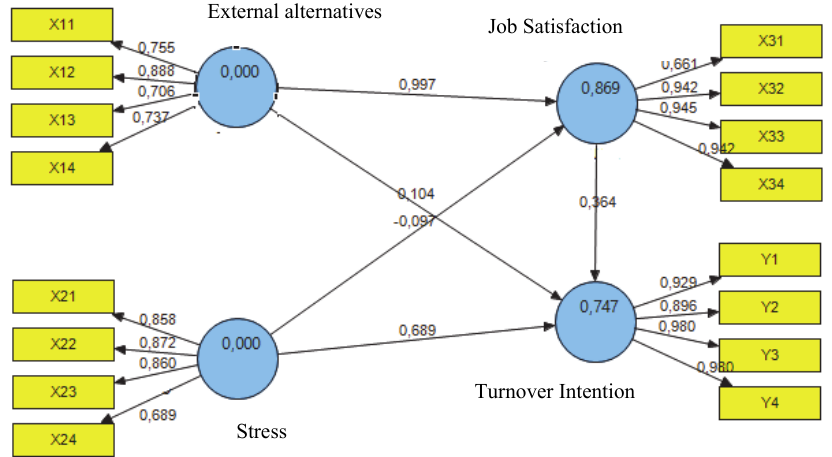
T Statistics (|O/STERR|)